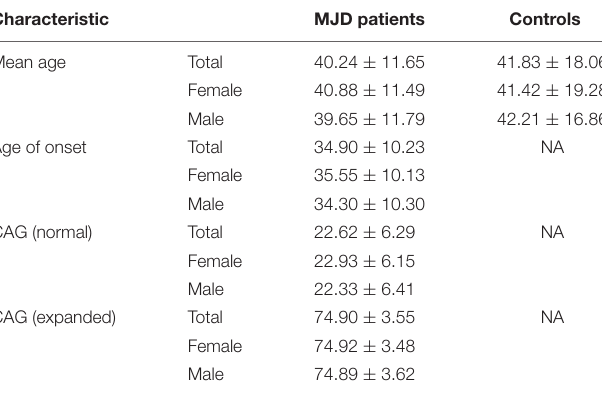
TABLE 1 | Characteristics of the controls and MJD